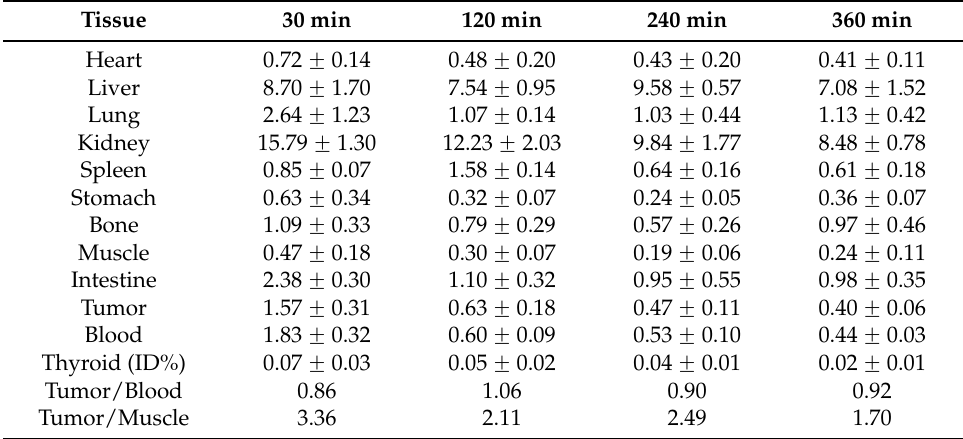
Table 3. Biodistribution of 7c in mice bearing S180 tumor (mean ˘ SD, n = 4, %ID/g). Tissue